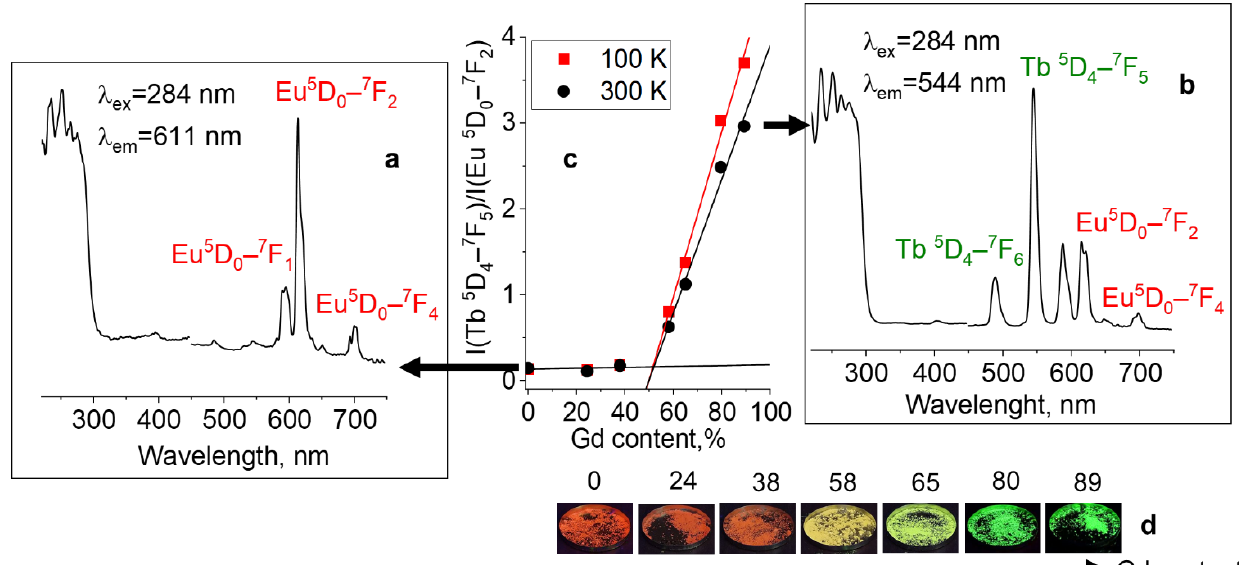
Figure 8. Excitation (225–450 nm) and emission (450–750 nm) spectra of layered basic sulfobenzoates ( a ) Tb 0.9 Eu 0.1 and ( b ) Gd 0.9 Tb 0.09 Eu 0.01 . ( c ) The ratio of luminescence intensities I (Tb 5 D 4 – 7 F 5 )/ I (Eu 5 D 0 – 7 F 2 ) in solid solutions of (Gd 1 − x Tb 0.9 x Eu 0.1 x ) 3 (OH) 7 (C 7 H 4 O 5 S)· n H 2 O as a function of gadolinium content at different temperatures (100 K, 300 K). ( d ) The appearance of powders under UV light (254 nm).